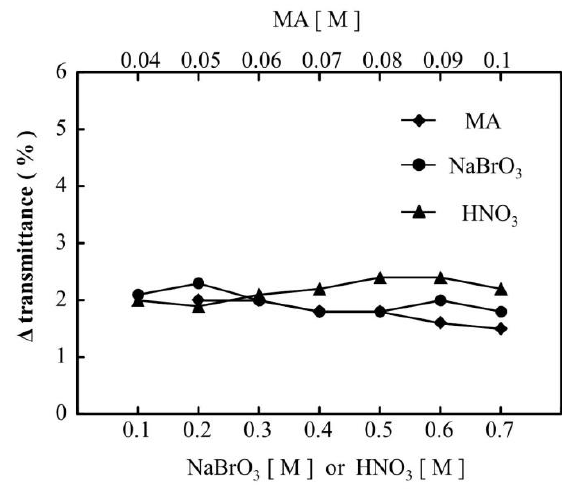
Figure 5. Dependence of amplitude of transmittance self-oscillation for polymer solution at 14 °C in the change in one BZ substrate under fixed concentrations of the other two BZ substrates: MA ([MA] = 0.04, 0.05, 0.06, 0.07, 0.08 and 0.09 M, fixed [NaBrO and [HNO ] = 0.3 M); NaBrO ([NaBrO ] = 0.1, 0.2, 0.3, 0.4, 0.5 and 0.6 M, fixed 3 3 3 [MA] = 0.1 M and [HNO ] = 0.3 M); HNO ([HNO ] = 0.1, 0.2, 0.3, 0.4, 0.5 and 0.6 M, 3 3 3 fixed [NaBrO ] = 0.1 M and [HNO ] = 0.3 3 3